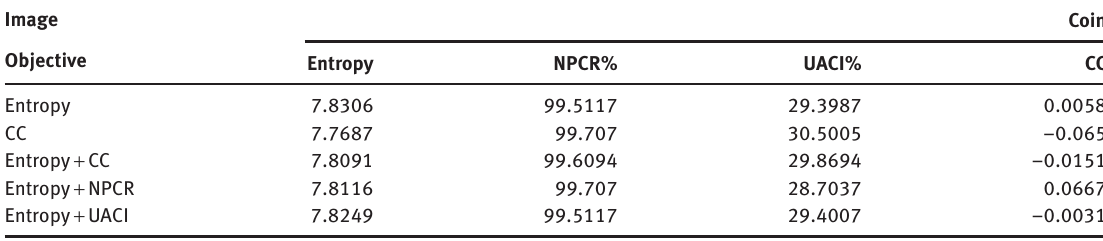
Table 3: Comparative Analysis for Coin Image Using Logistic Map Function.